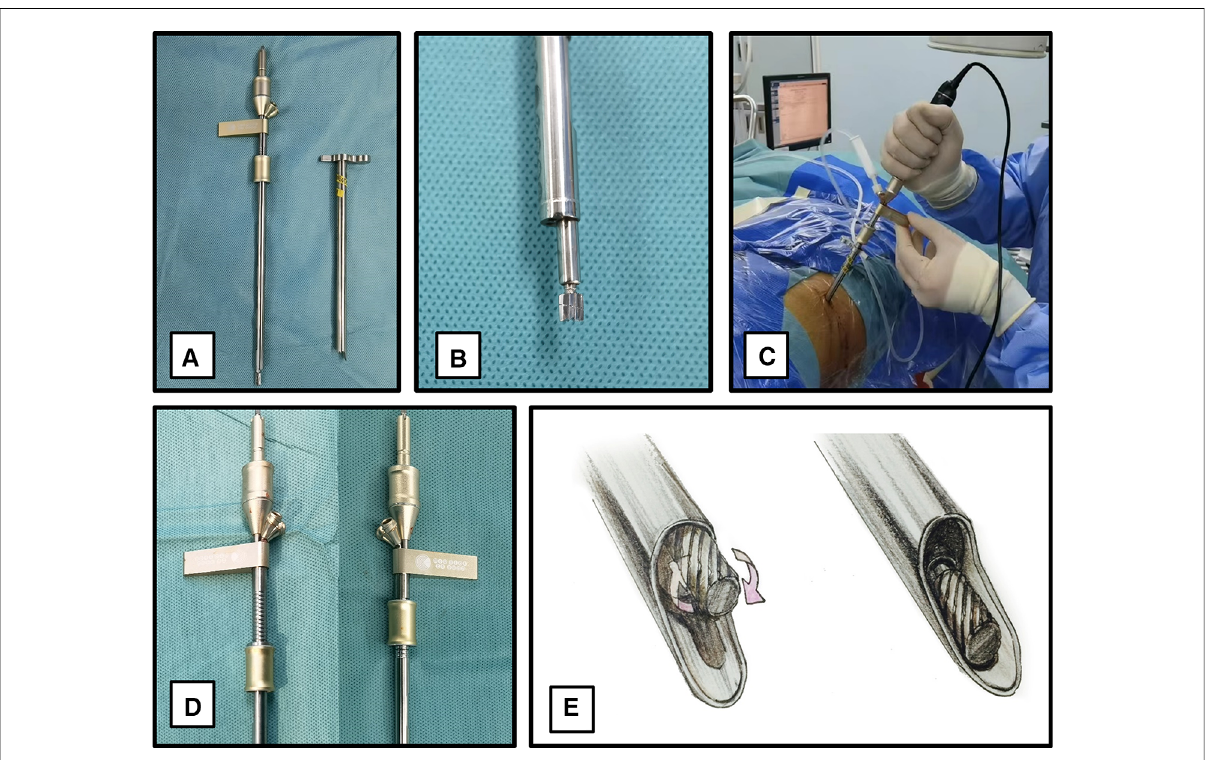
FIGURE 1 Power-aided reciprocating burr instrument. ( A ): A power-aided reciprocating burr. ( B ): An decentered cylindrical burr head. ( C ): Four main components of the instrument. ( D ): The control apparatus, which can slide on the graduated scale. ( E ): The movement mode of the decentered cylindrical burr after connecting the handle is